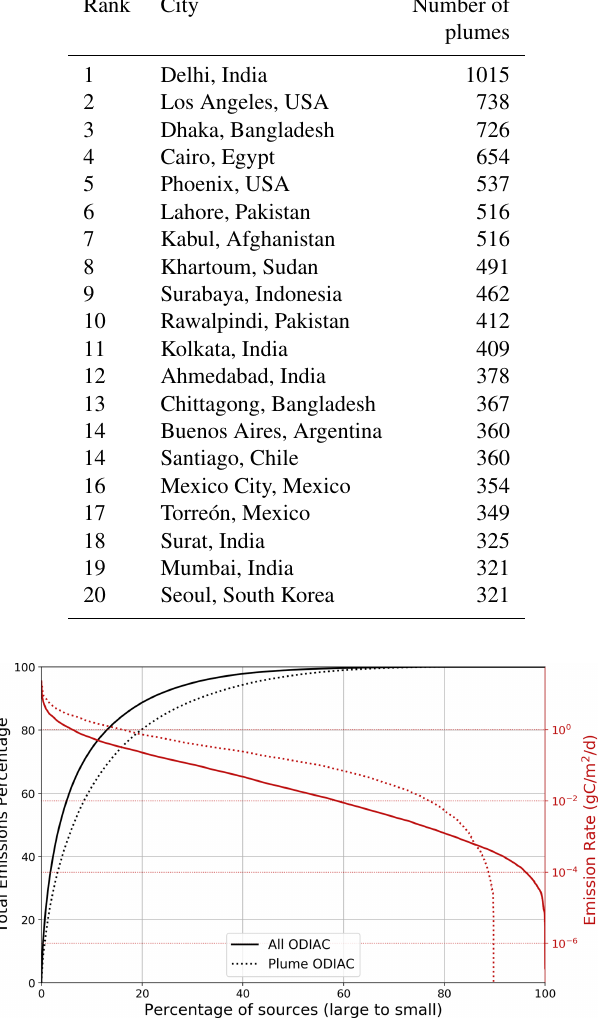
Figure 5. The cumulative total emission percentage as a function of source size (black) and emission rate as a function of source size (red) for all ODIAC (solid line) and ODIAC sampled at plume lo- cations (dotted